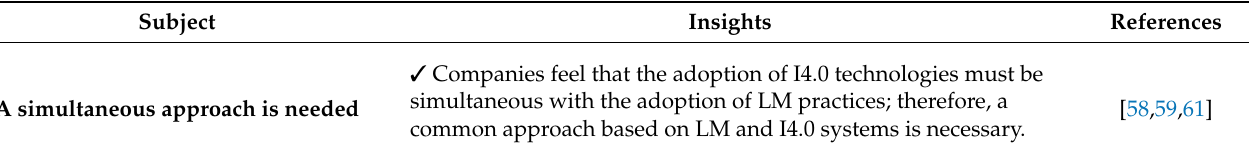
Table A3. Empirical approaches for the application of I4.0 to